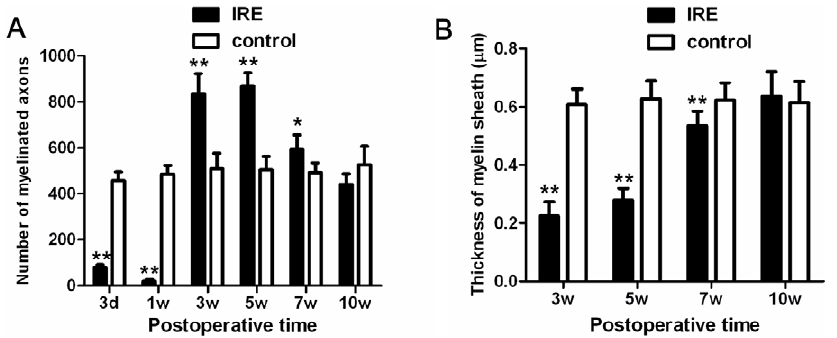
Figure 4. Histological analysis of target muscle. (a–f) Hematoxylin and eosin staining. Light micrographs of transverse sectioned gastrocnemius muscle on the IRE side at 3 days, 1 week, 3, 5, 7 and 10 weeks after injury. Scale bars : 10 m m.